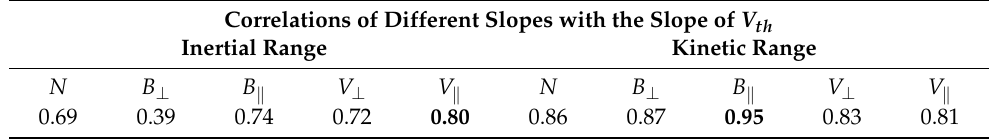
Figure 8. A comparison of median slopes of V th and N (top panels) and V th and V (cid:107) (bottom panels), respectively in inertial (left panels) and kinetic (right panels) ranges. Red points in particular panels mark values of slopes for the full set of events. Table 2. Correlations between the median slopes of V th and the slopes of other solar wind parameters and magnetic field determined for different subsets in inertial and kinetic ranges. The greatest correlation in each range is